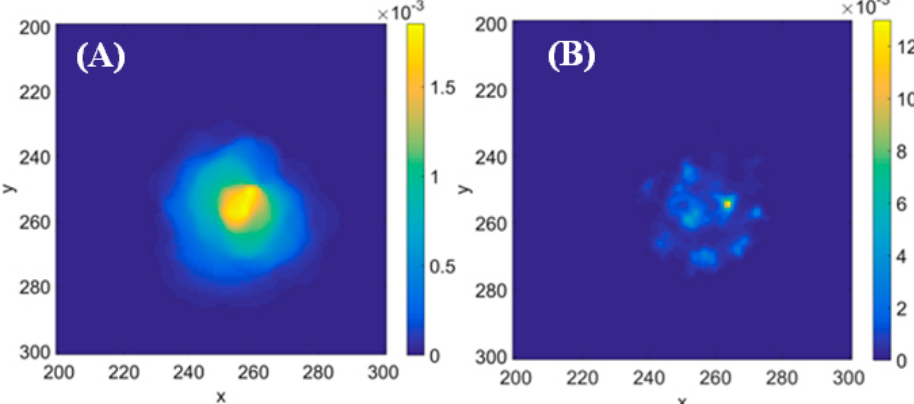
Figure 2. Examples of concentration distributions of a marker spreading from a single point within Hänggi–Klimontovich’s ( A ) and Ito’s ( B ) realisations of the random walk in the medium with Gamma- distributed and then locally correlated (with the correlation length (cid:96) = 10 lattice sites) local diffusivity. Reproduced from [69] (published there under Creative Commons Attribution 4.0